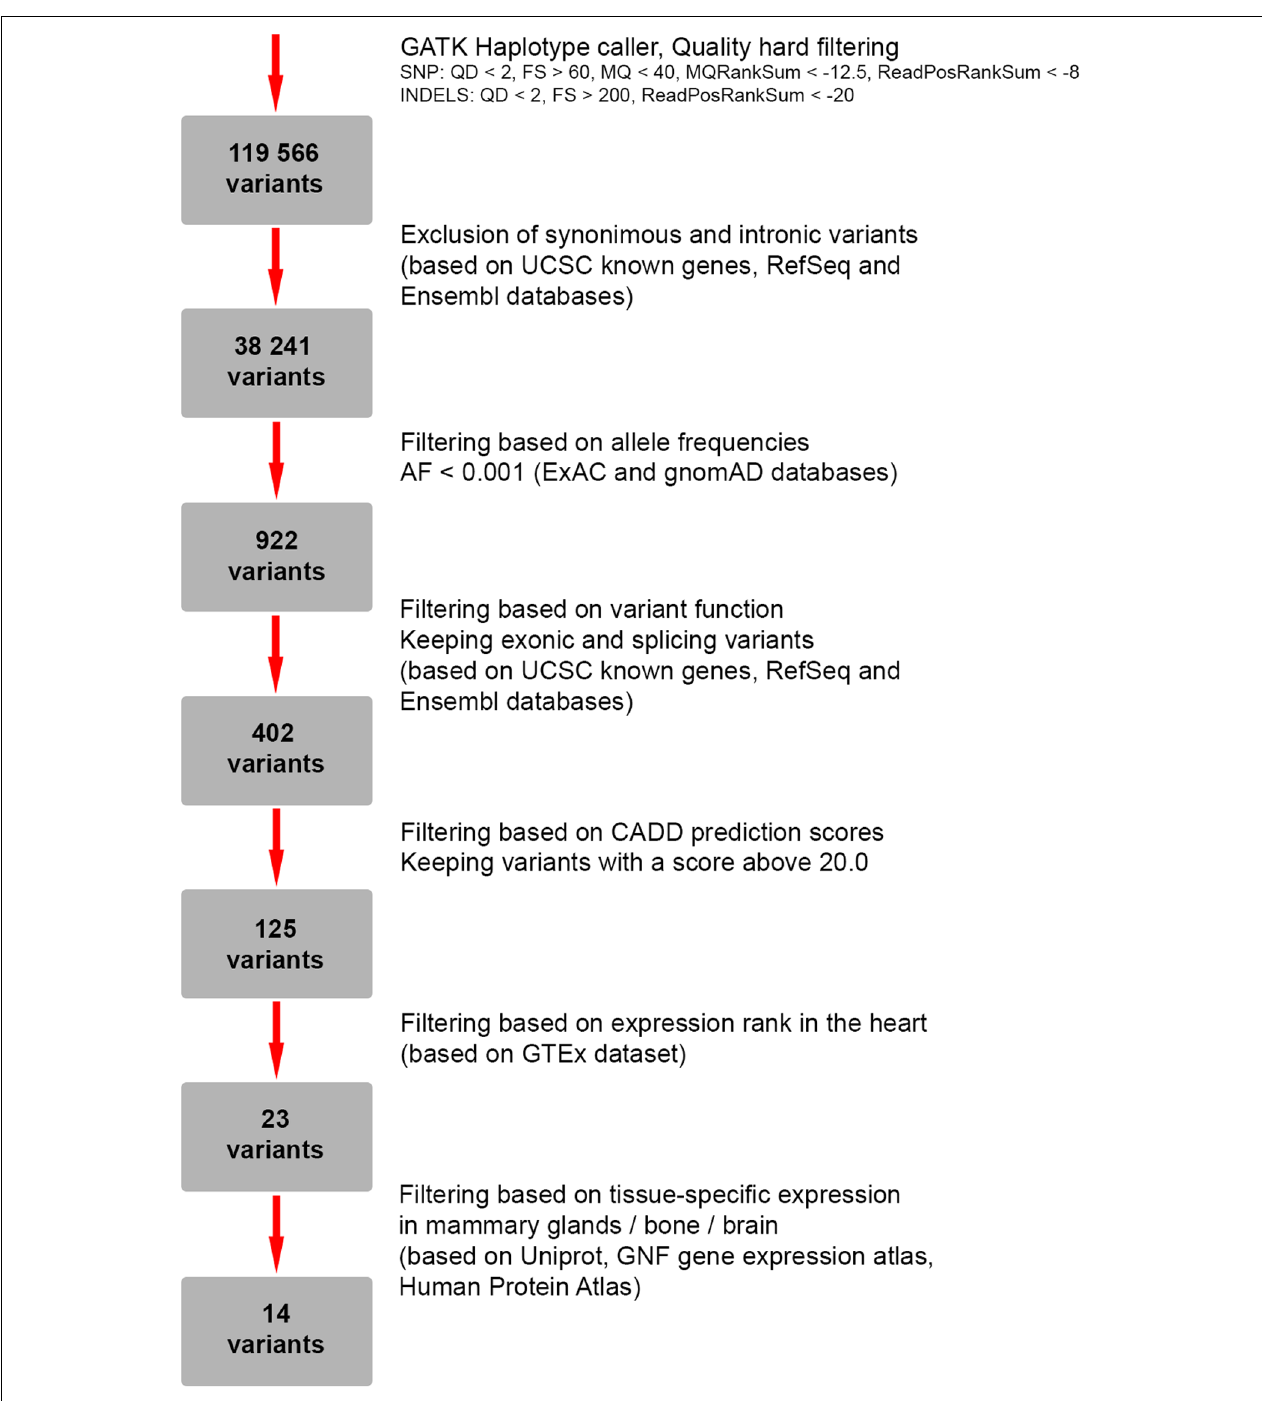
FIGURE 2 | Flowchart representing a strategy for filtering of genetic variants identified by whole-exome sequencing (WES).